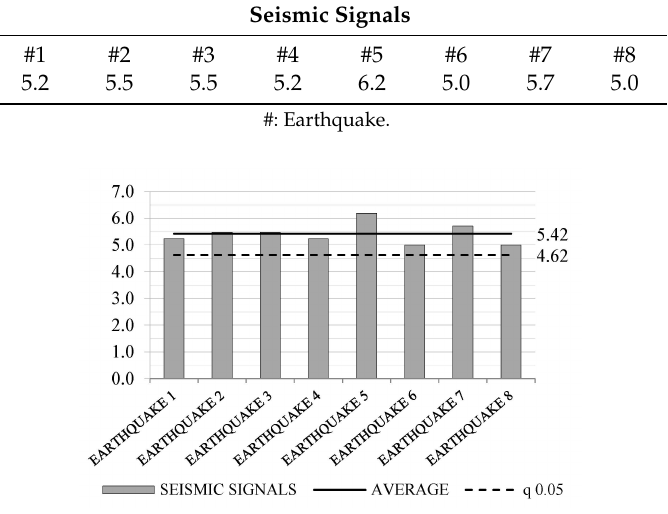
Figure 15. Obtained q -factor values, average value and 5% characteristic